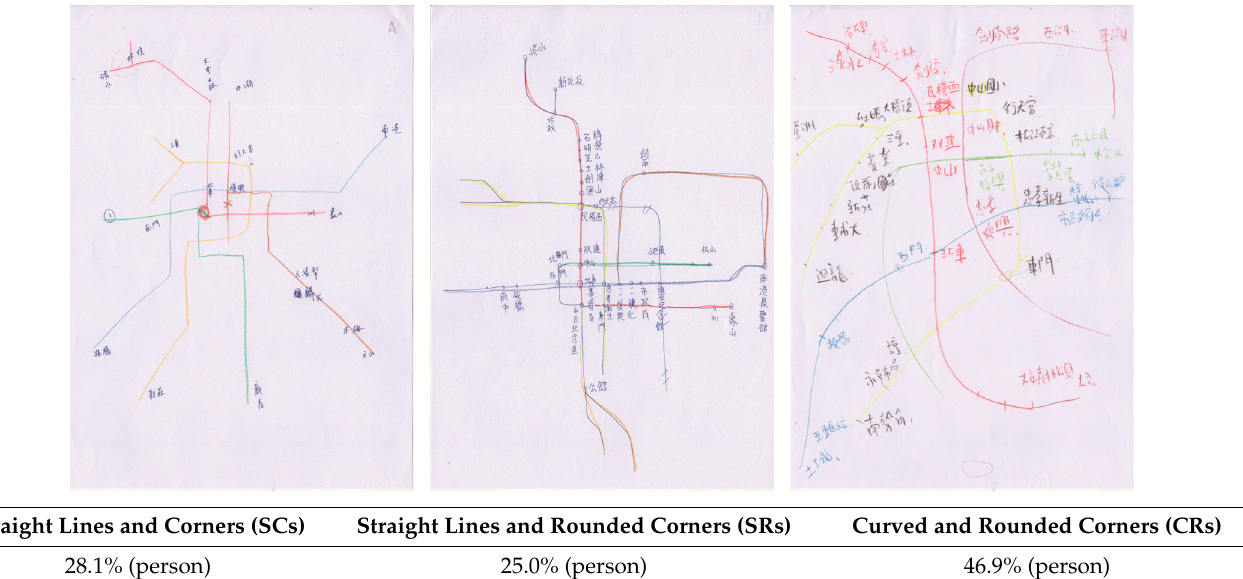
Table 3. Statistical results on the most frequently used elements in drawing a route map based on cognitive mapping. In drawing the cognitive route map, 90.6% of the participants used colors to facilitate memorization; 68.8% of these participants used the five correct colors to draw the five main routes. The number of women using colors was significantly higher than that of men using colors ( p = 0.003 [<0.05]), indicating that color was among the factors related to par- ticipants’ memory of the route map. We found that among the elements used by the par- ticipants, transfer stations, terminal stations, and features of route forms were widely used. Overall, 96.9% of the participants drew transfer stations, and 93.8% drew terminal stations. The percentage of those who drew transfer stations was significantly correlated with the participants’ metro usage experience ( p = 0.0016 [<0.05]) (Table 3). Participants taking the metro more frequently drew more transfer stations, and those who drew more